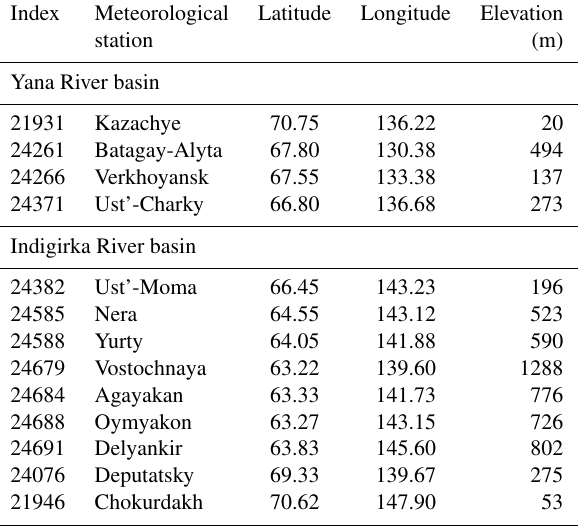
Table 2. Characteristics of meteorological